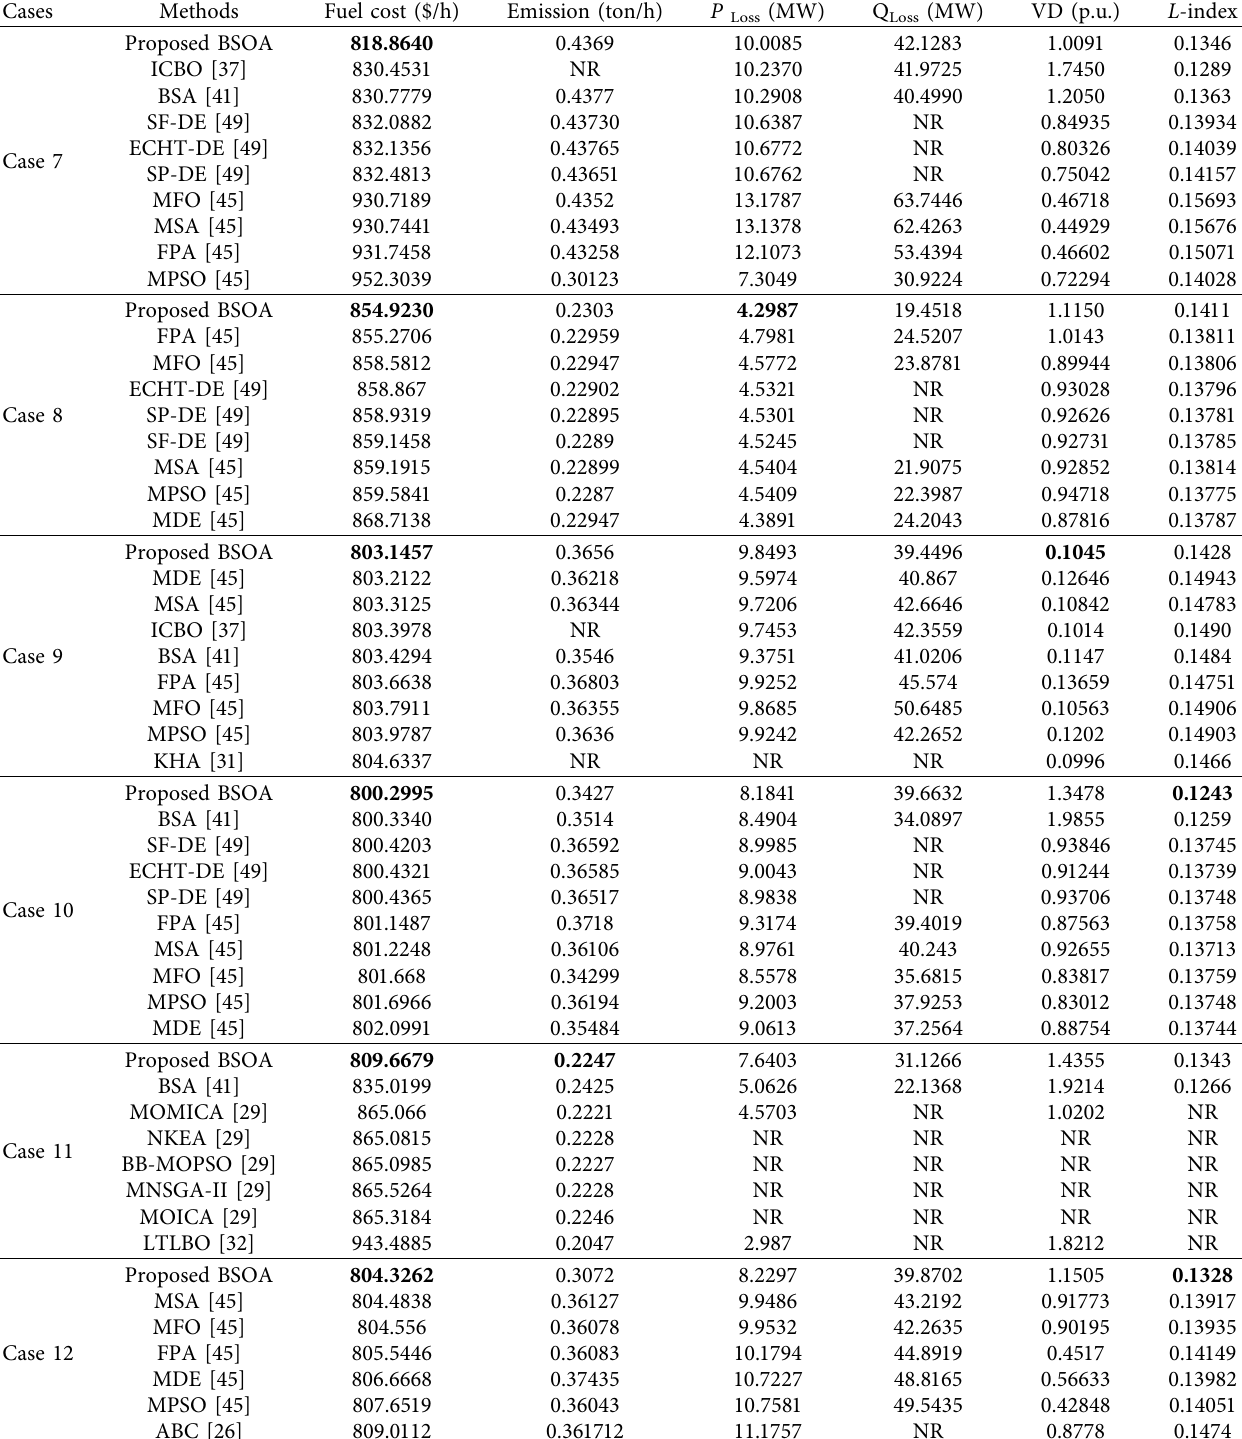
Table 6: An extensive comparison of the proposed BSOA method with previous recent studies for multiobjective cases (Case 7 to Case 13) in the IEEE 30-bus